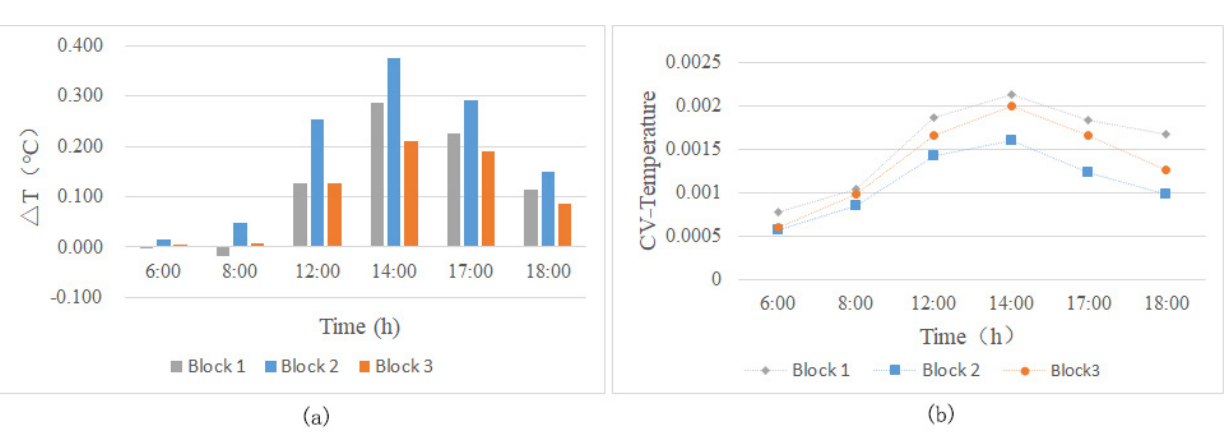
Figure 5. ( a ) Variation of the ∆ T values and ( b ) CV of the Ta values for the three green space network patterns during typical diurnal hours.